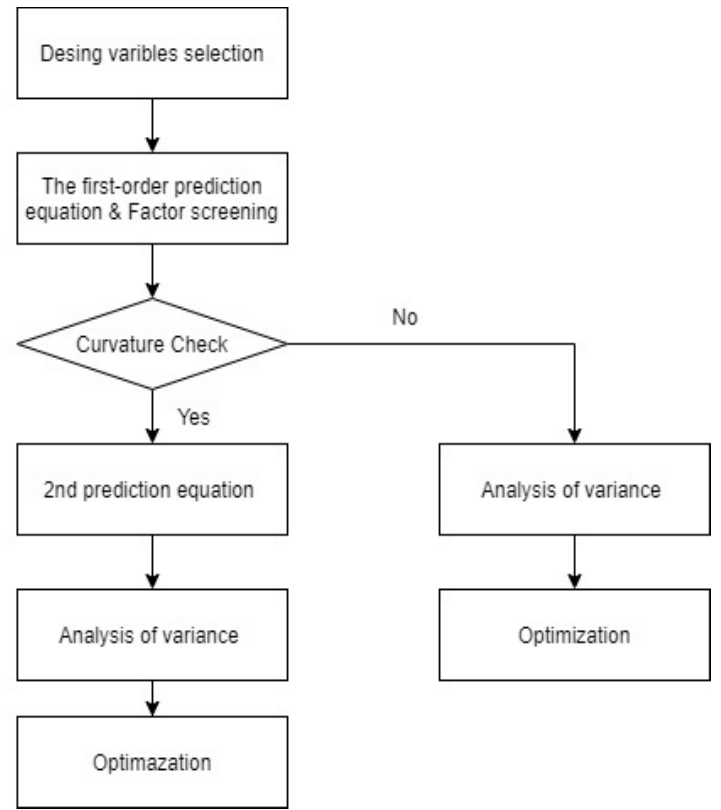
Figure 4. Flow chart of design of experiment (DOE).